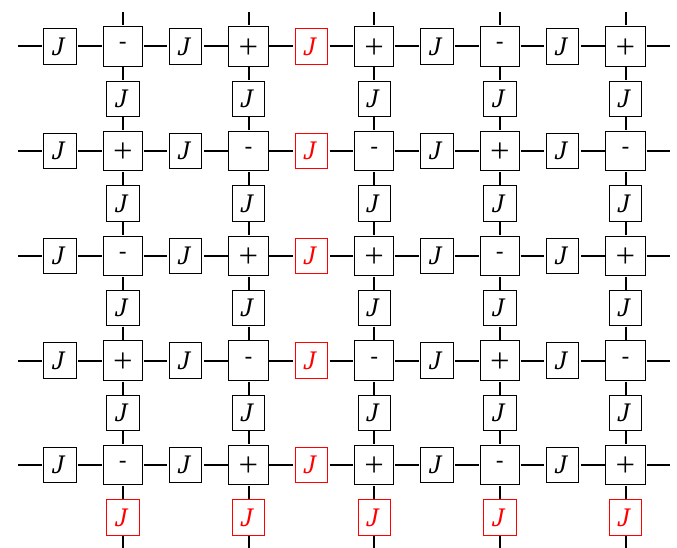
Figure 25: An example of one of the ground states of the antiferromagnetic Ising model on a 2D periodic square lattice with odd shape in both dimensions, in this case 5 × 5. Red boxes indicate frustrated